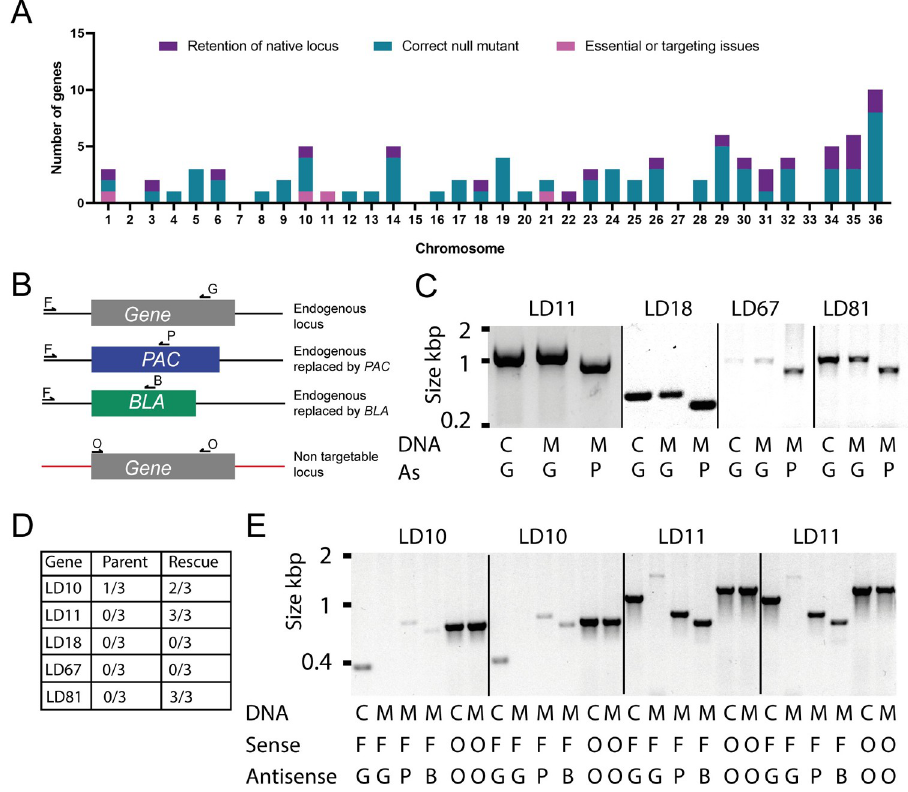
Fig 2. The failure to obtain some null mutants is unlikely to be due to aneuploidy or inability to correctly target the gene. ( A ) Graph showing the success of gene targeting on individual chromosomes. The number of successfully targeted genes is shown in teal, failure to recover viable promastigotes in pink, and dual drug resistant parasites retaining a copy of the native loci in purple. Chromosomes 26 and 31 are present in multiple copies per haploid genome. ( B ) Schematic of the diagnostic PCRs used to genotype parasites. ( C ) Diagnostic PCRs demonstrating the expected monoallelic targeting of genes with just the puromycin-selection cassette for genes that had failed to recover doubly-drug resistant parasites. The indicated genomic DNAs are: wild-type control, C or puromycin-resistant mutant parasites, M, which were used as PCR templates using a shared sense primer (F) and the indicated antisense primer as shown in the schematic. ( D ) Table showing the frequency of being able to recover doubly drug resistant parasites in the presence (Rescue) or absence (Parent) of a non-targetable version of the named genes. ( E ) Confirmation of correct integration of drug resistance markers into the LdBPK_292250.1 (LD10) and LdBPK_211610.1 (LD11) loci only in the presence of a non-targetable copy of the gene under constitutive expression. Genotyping for LD10 and LD11 is shown for two independently selected populations.